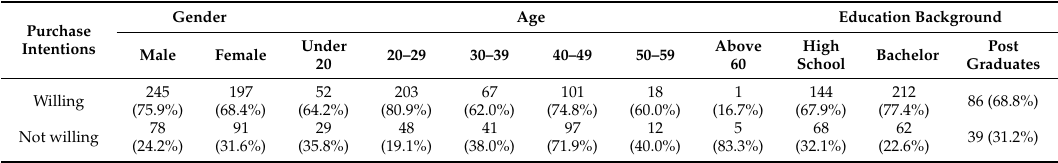
Table 4. Purchase intentions of residents on remanufactured